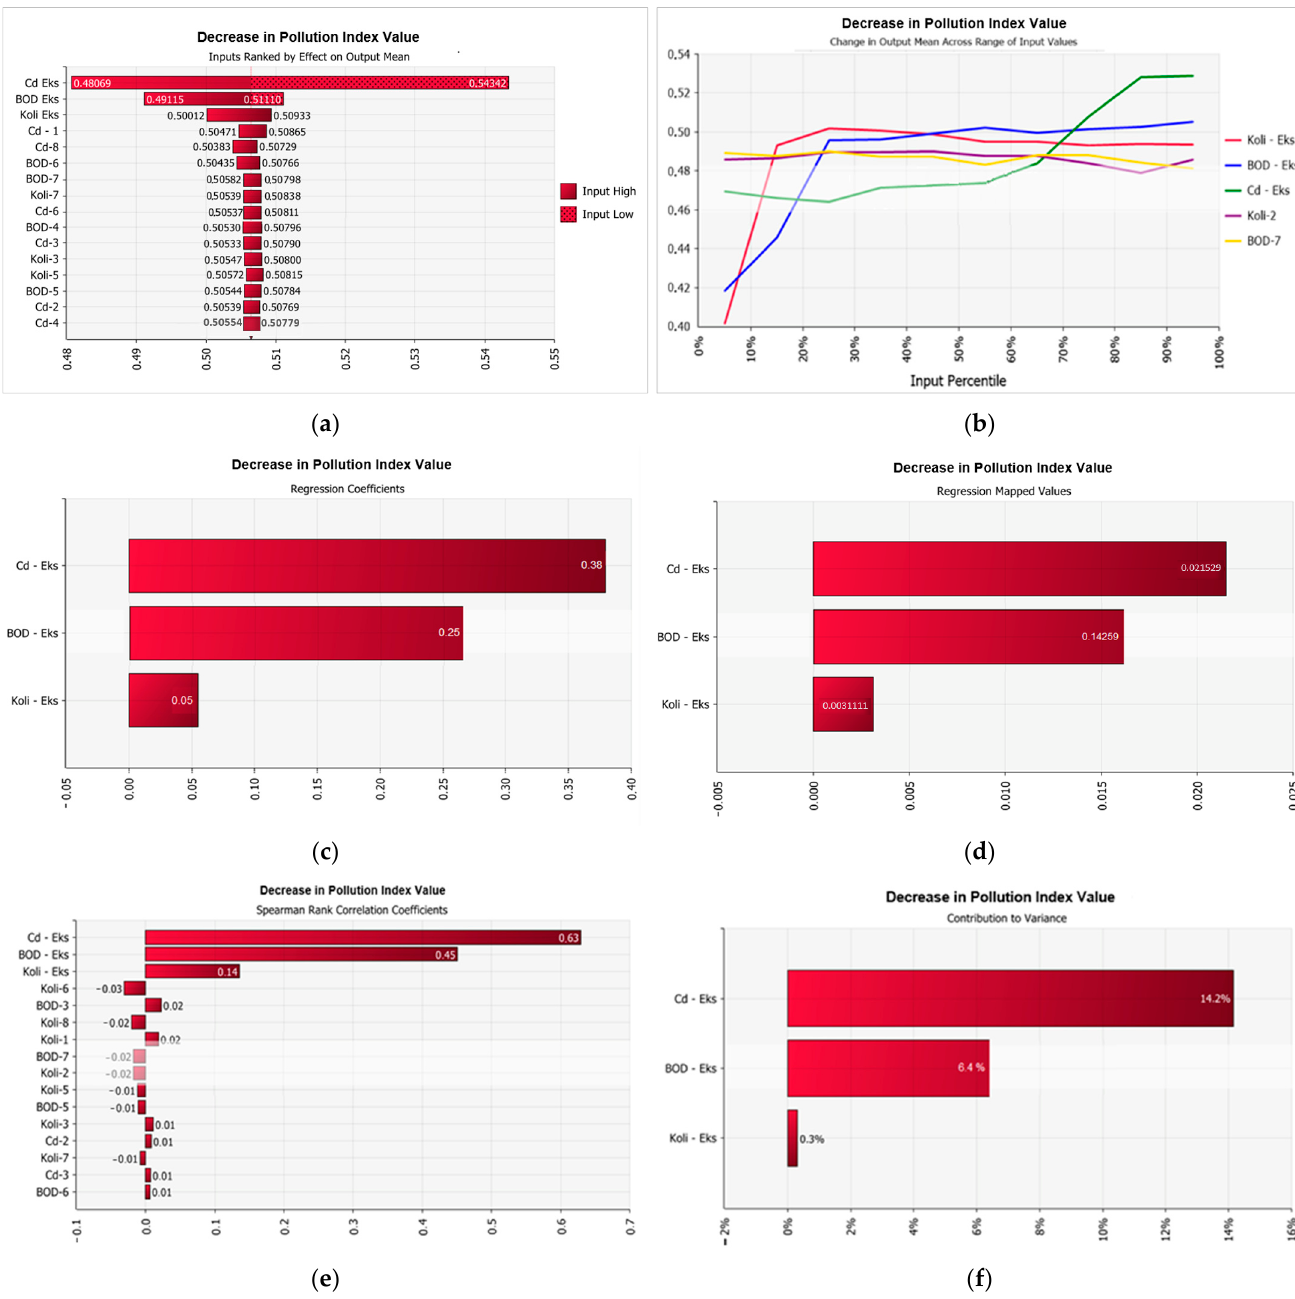
Figure 5. Uncertainty input: ( a ) tornado—change in output statistic; ( b ) spider—change in output statistic; ( c ) tornado—change in regression coefficient; ( d ) tornado—regression mapped values; ( e ) tornado—correlation coefficient; ( f ) tornado—contribution to variance.